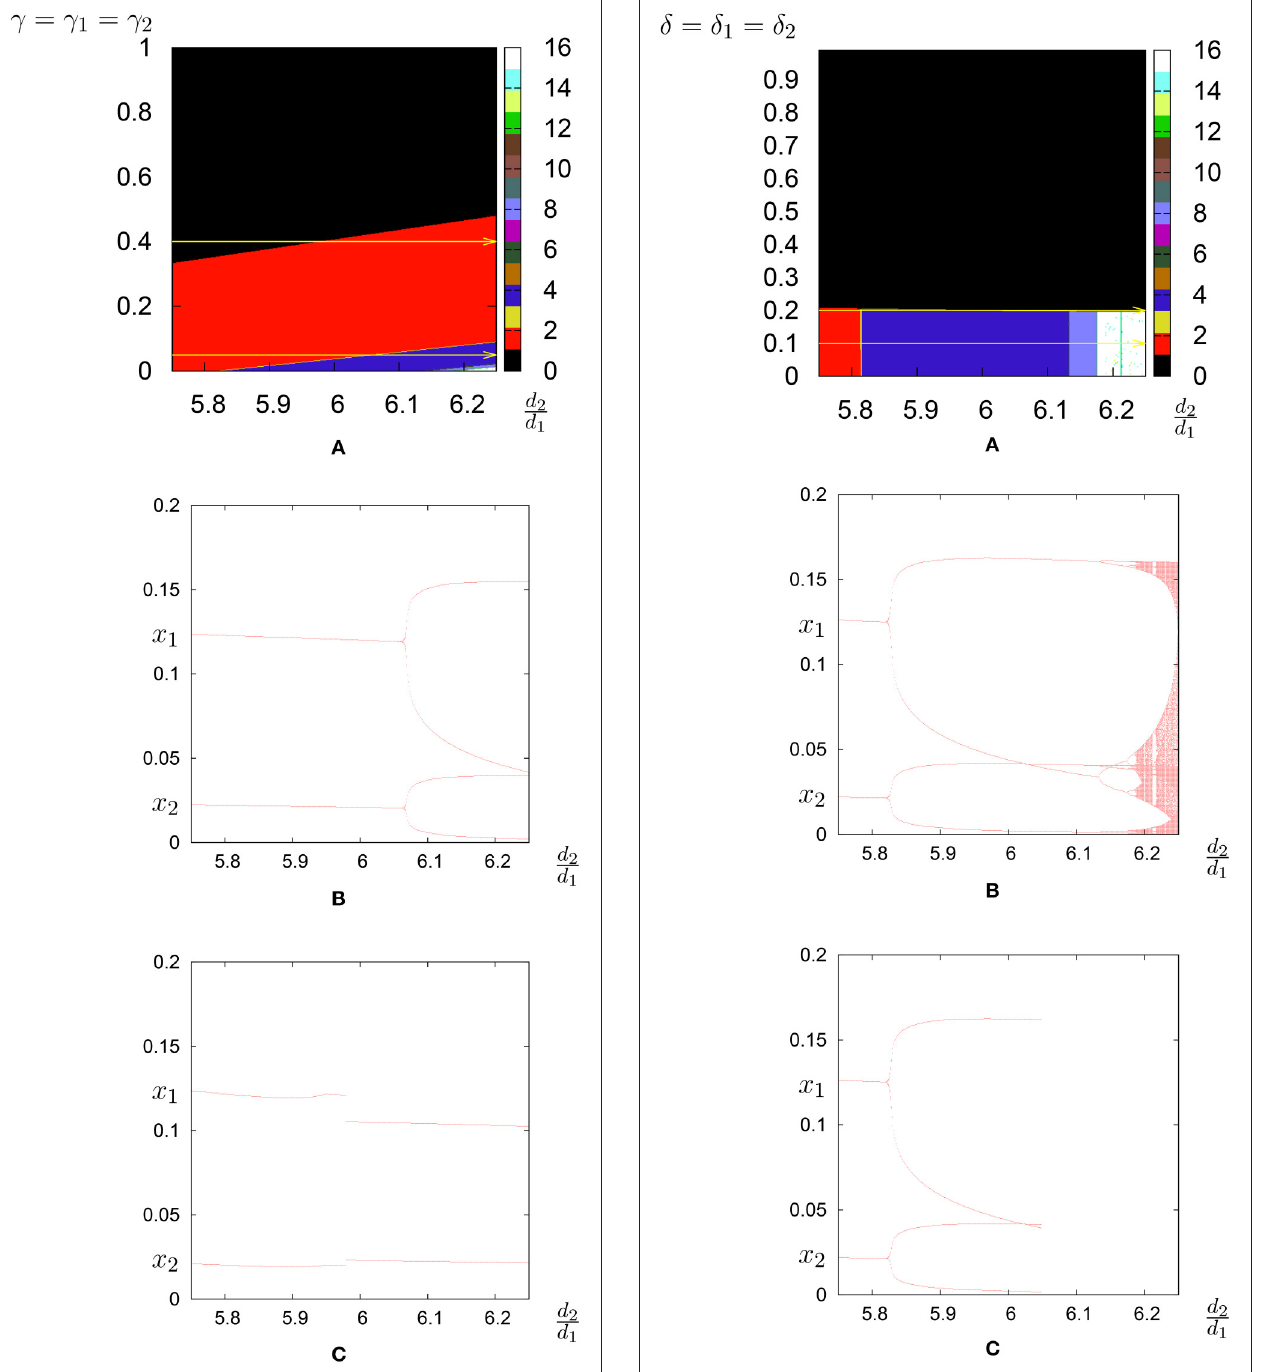
FIGURE 12 | Hiring cost. (A) Bifurcation diagram in the parameter plane d 2 / d 1 , γ γ 1 γ 2 ; the regions of different periodicity are represented by = = different colors. The horizontal yellow line represents the line on which, in (B) , (cid:0) (cid:1) γ 1 γ 2 the bifurcation diagram is shown with γ 0.05, and in (C) , the = = = γ 1 γ 2 bifurcation diagram is shown with γ 0.4. = = =